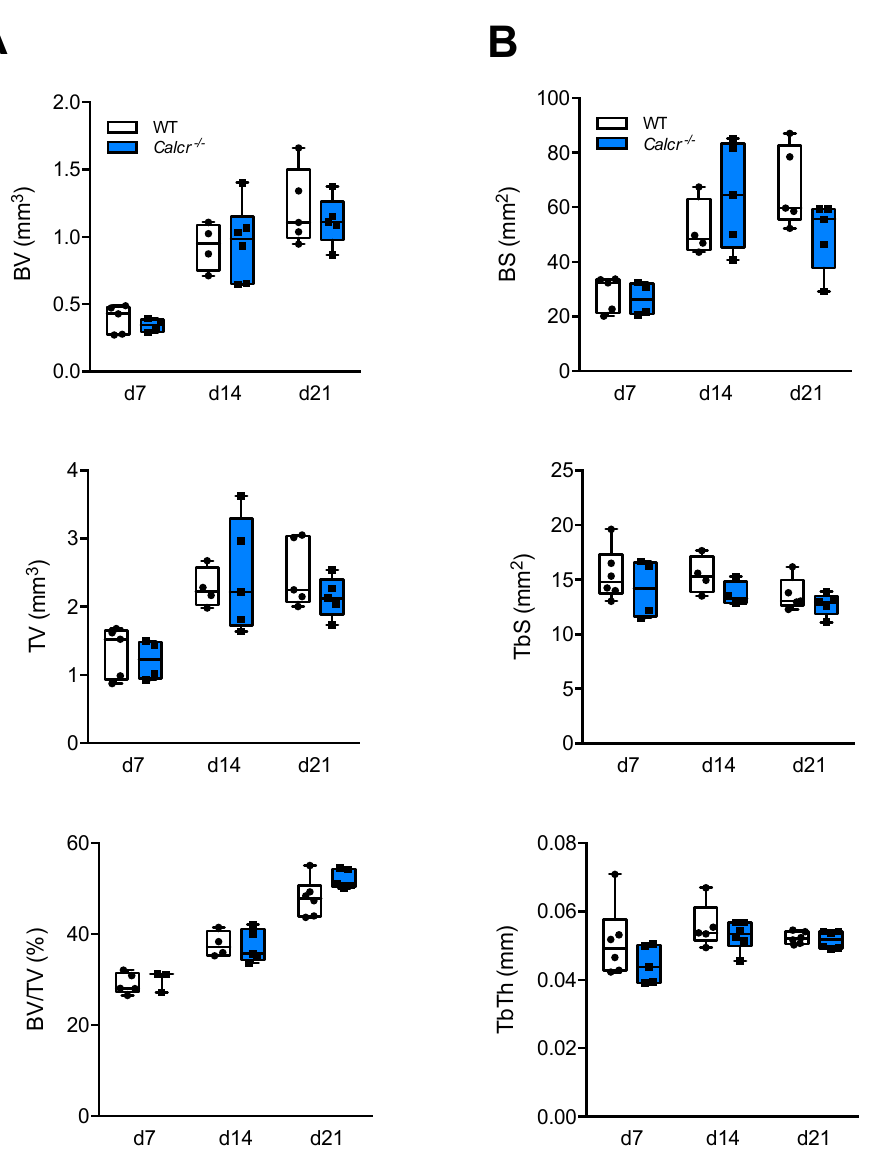
Figure 3. Quantification of µ CT callus images. ( A ) Quantitative analysis of µ CT images in mice of both genotypes at the same time points. BV = total callus bone volume (i.e., newly mineralized bone volume), TV = total tissue volume (i.e., total callus volume), BV/TV = bone volume vs. tissue volume. ( B ) Quantitative analysis of µ CT images in the same samples. BS = bone surface, TbS = trabecular surface, TbTh = trabecular thickness. For ( A , B ) n = 3–6 mice per group and time point as indicated. Box plots represent median with minimum and maximum whiskers.